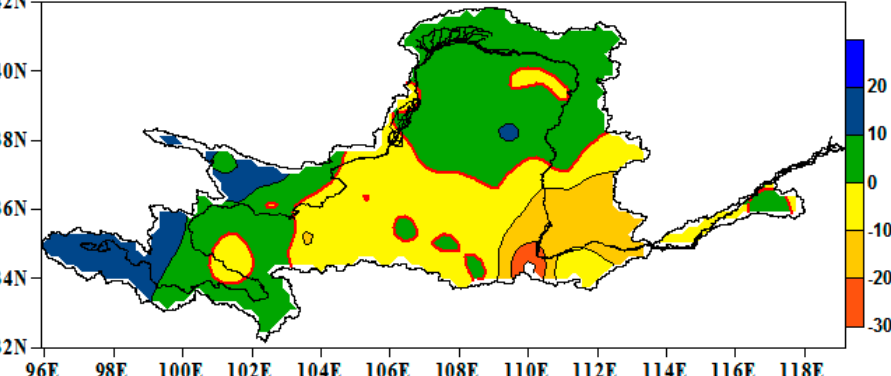
Figure 2. Spatial distribution of temperature change over the YRB (unit: °C decade − 1 ).